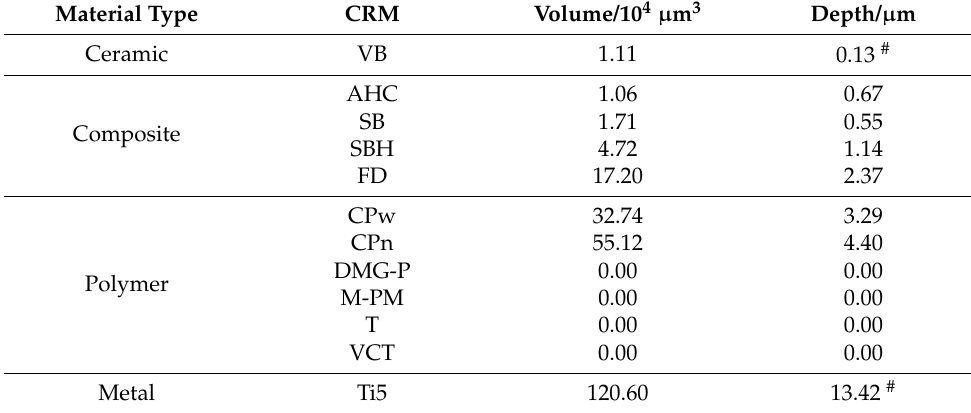
Table 2. Characteristics of Leeb